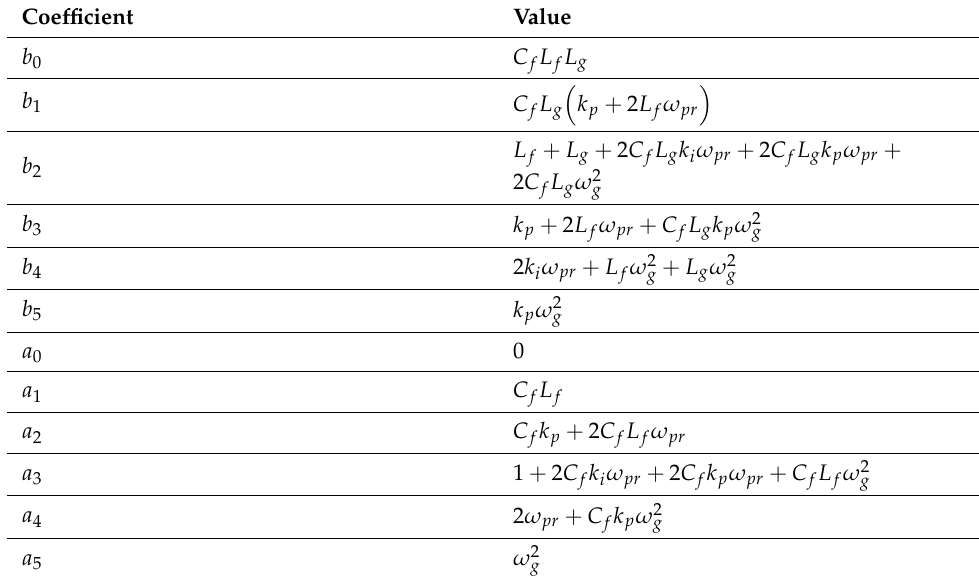
Table 2. Coefficients of the transfer function of Z o ( s ) .